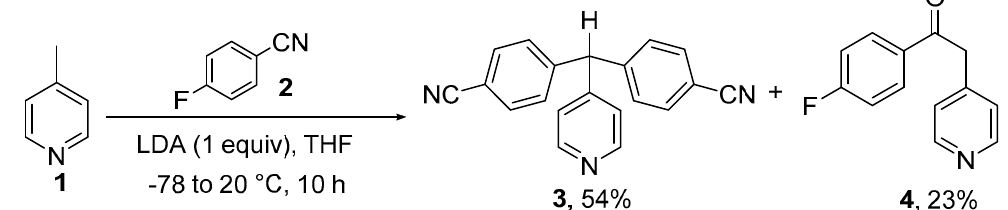
Figure 2. The synthetic scheme by which the title compound 3 was synthesised, alongside a by-product, 4 (percentage yield calculated from the amount of 4-fluorobenzonitrile ( 2 ) starting material, with 1 treated as being in excess) [7,12].